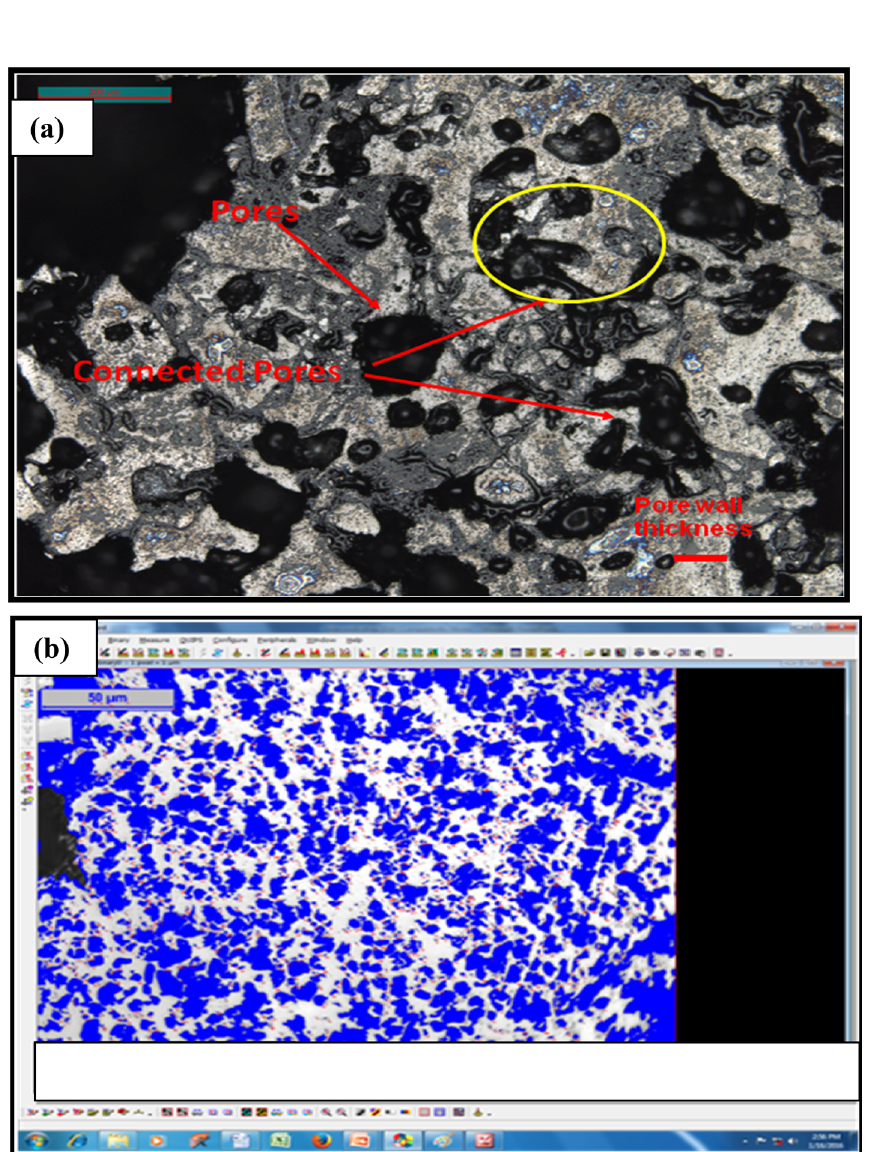
Fig. 3 a Microphotographs showing structure of cokes, b image analysis methodology showing pore distribution in coke samples